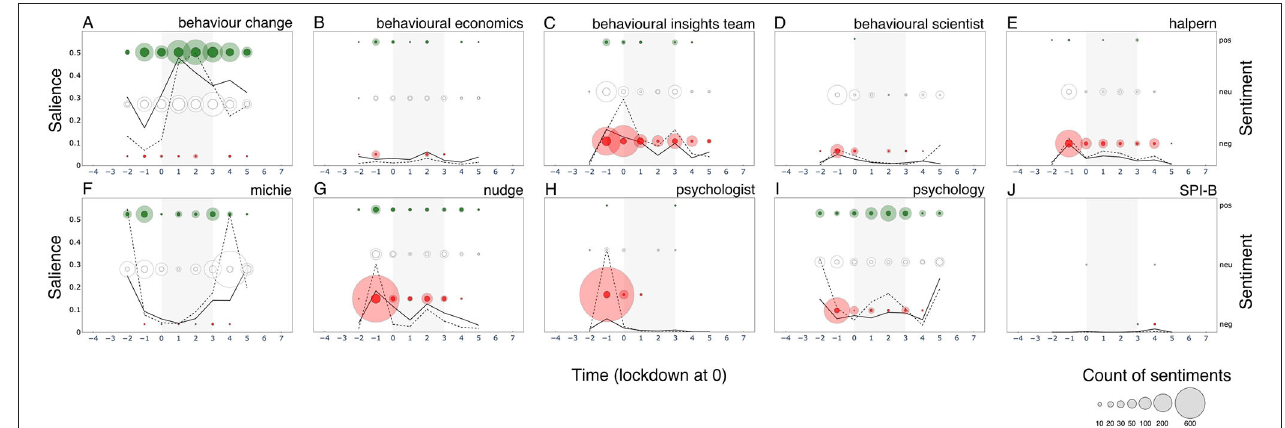
FIGURE 10 | Twitter - Salience of and sentiment toward primary keywords over 8 two-week time-period surrounding the first British national lockdown of 2020 (in gray): (A) behaviour change (concept), (B) behavioural economics, (C) behavioural insights team (named actor), (D) behavioural scientist (unnamed actor), (E) halpern (named actor), (F) michie (named actor), (G) nudge (concept), (H) psychologist (unnamed actor), (I) psychology (discipline), (J) SPI-B (names actor). Salience is calculated as the proportion of tweets in that 2-week period that mention the keyword. Bold line represents salience in original tweets; dotted line represents salience including retweets. The area of the bubbles is proportional to the count of sentiments (red = − 2, − 1; white = 0; green = + 1, + 2) toward the keyword. Full bubbles represent sentiments in original tweets only; shaded bubbles represent sentiments accounting for